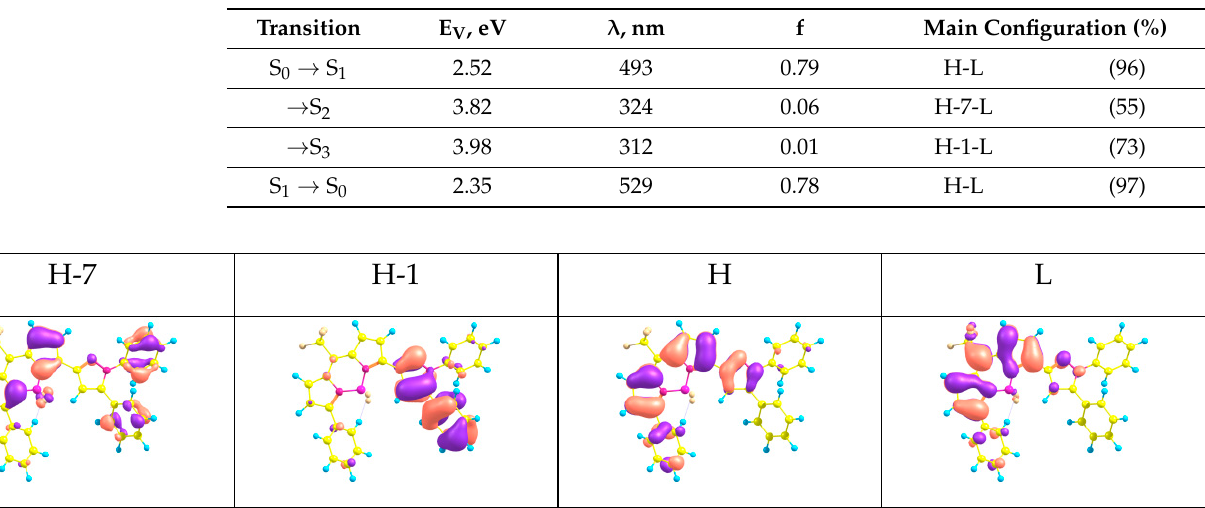
Figure 4. the Figure 4. The relevant molecular orbitals of BODIPY 1 calculated at the TD-CAM-B3LYP/def2-TZVP TD-CAM-B3LYP/def2-TZVP level of theory. level of